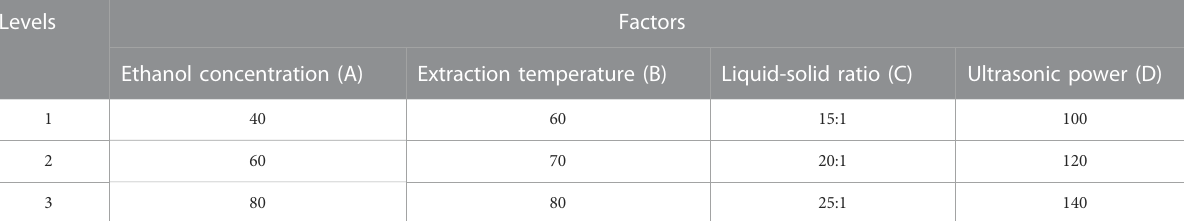
TABLE 1 Design of orthogonal experiment. Levels